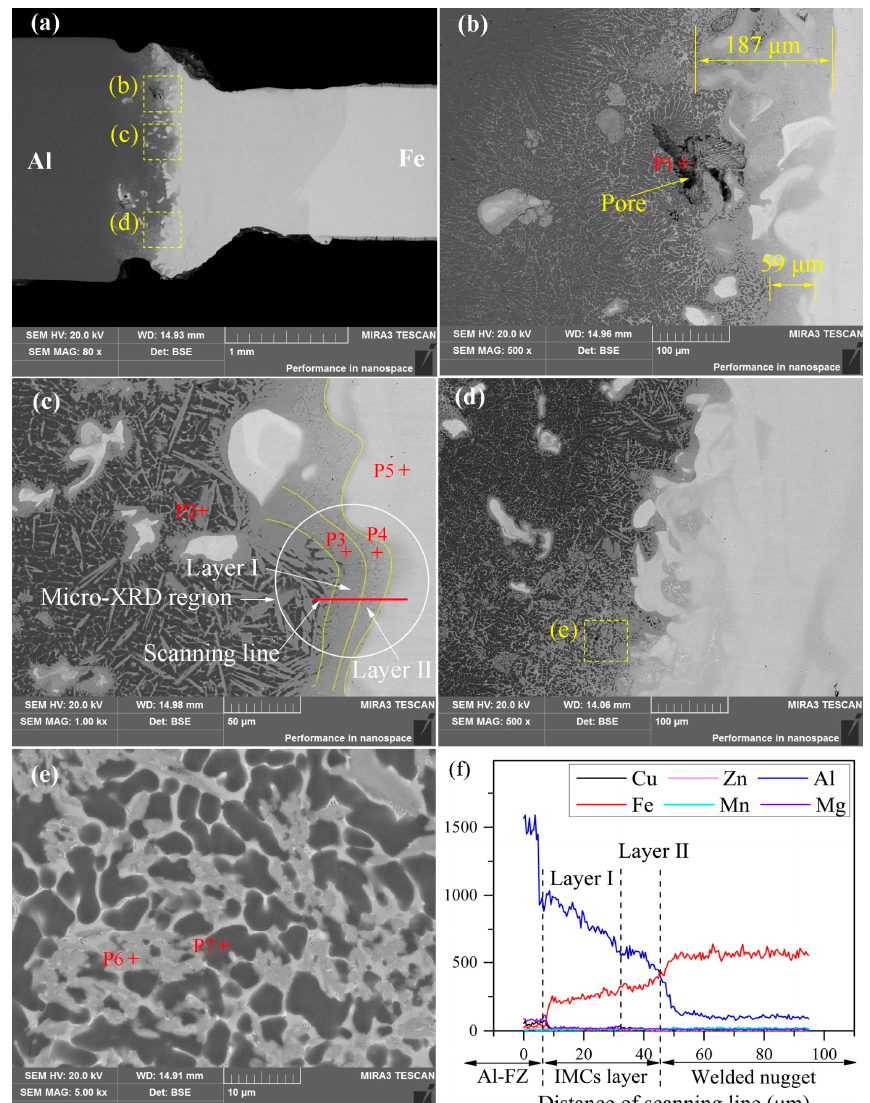
Figure 6. Interface microstructure of the joint. ( a ) Cross-sectioned macrostructure of the joint, ( b – d ) magnified views of the regions with the dotted square in ( a ), ( e ) a magnified view of the regions with the dotted square in ( d ), and ( f ) the energy-dispersive X-ray spectrometer (EDS) result of the scanning line marked with the red line in ( c ).